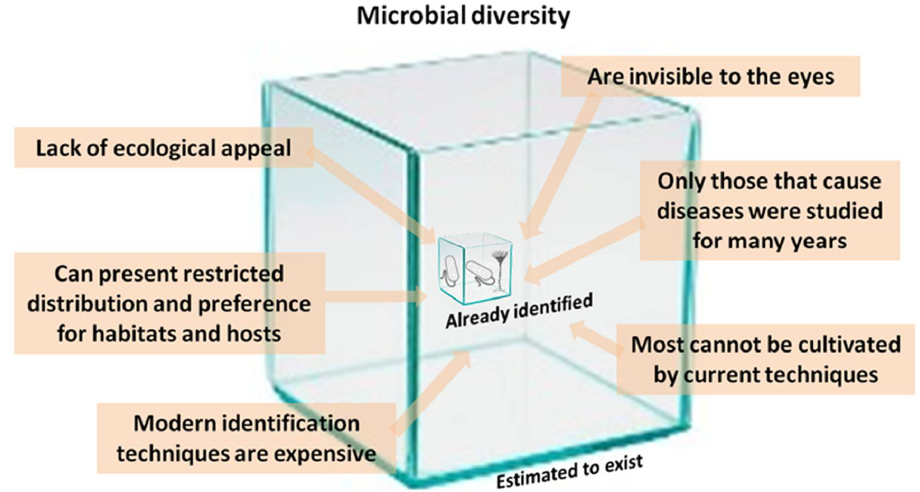
Figure 5. Comparative representation of the known and estimated (small box) and the yet unknown (large box) microbial diversity. The text boxes refer to factors that adversely affect the knowledge of the microbial diversity that exists on the planet.